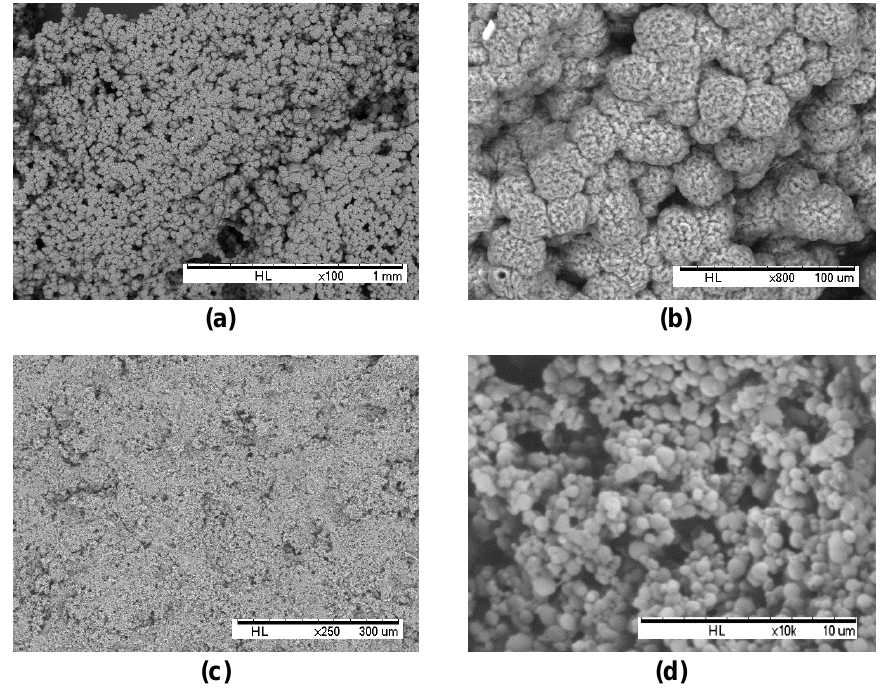
Figure 1. Scanning electron microscopy of ( a , b ) internally-structured polyhydroxyalkanoate microparticles (PHB-MP), and ( c , d ) non-structured polyhydroxyalkanoate submicron particles (PHB-SP), (note the different scales of magnification for the best representation of the particle morphology).